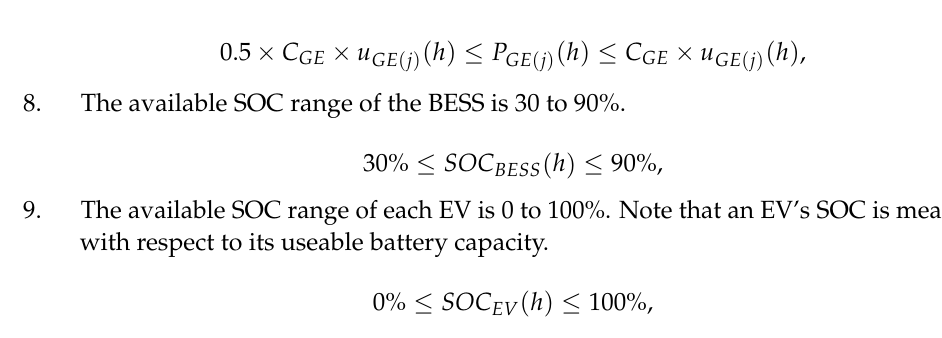
Table A1. Nomenclature of variables. P GE , PV , grid , BESS , surplus , shortage ( h ) Power output of a power system component during simulation hour ( h ) P EV , charge / discharge ( h ) Charging/discharging power of EVs during simulation hour ( h ) C GE , grid , BESS , EV Maximum power output of a power system component SOC BESS , EV ( h ) SOC of BESS/EV during simulation hour ( h ) GE cost functions ( α GE = JPY 3022.4, α GE , β GE β GE = JPY 166.4) Penalties for PV power curtailments, power surplus or power shortages γ penalty PV , surplus , shortage Dummy prices for controlling EV charging/discharging